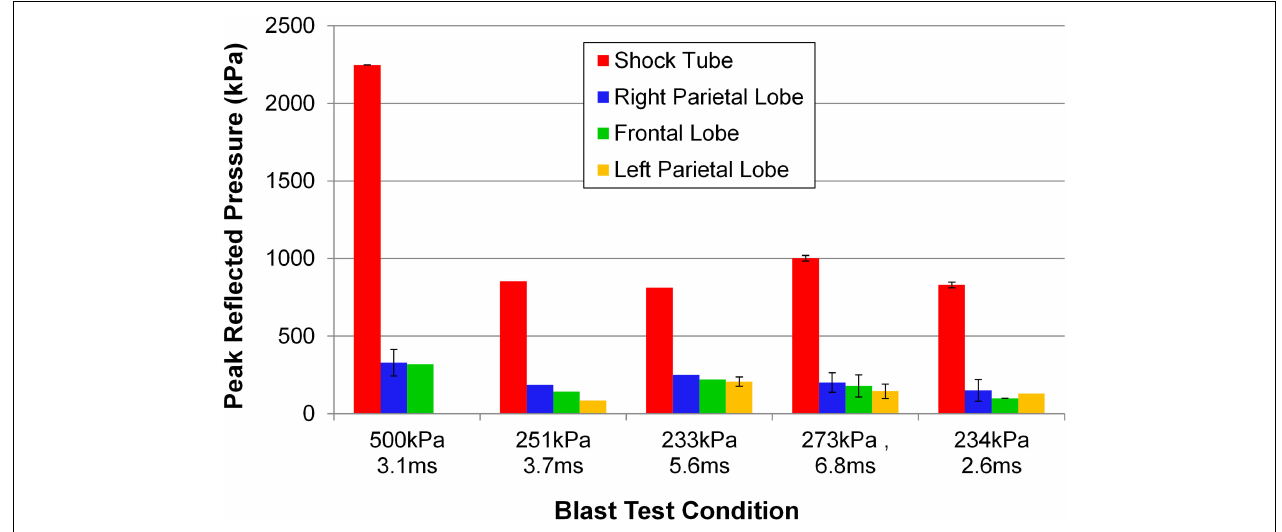
FIGURE 6 | Pressure measured at the surface of the porcine head and the intracranial pressure measured at various locations for a shock impacting the right side of the pig’s head. The blast test conditions vary in peak incident overpressure and positive phase duration.